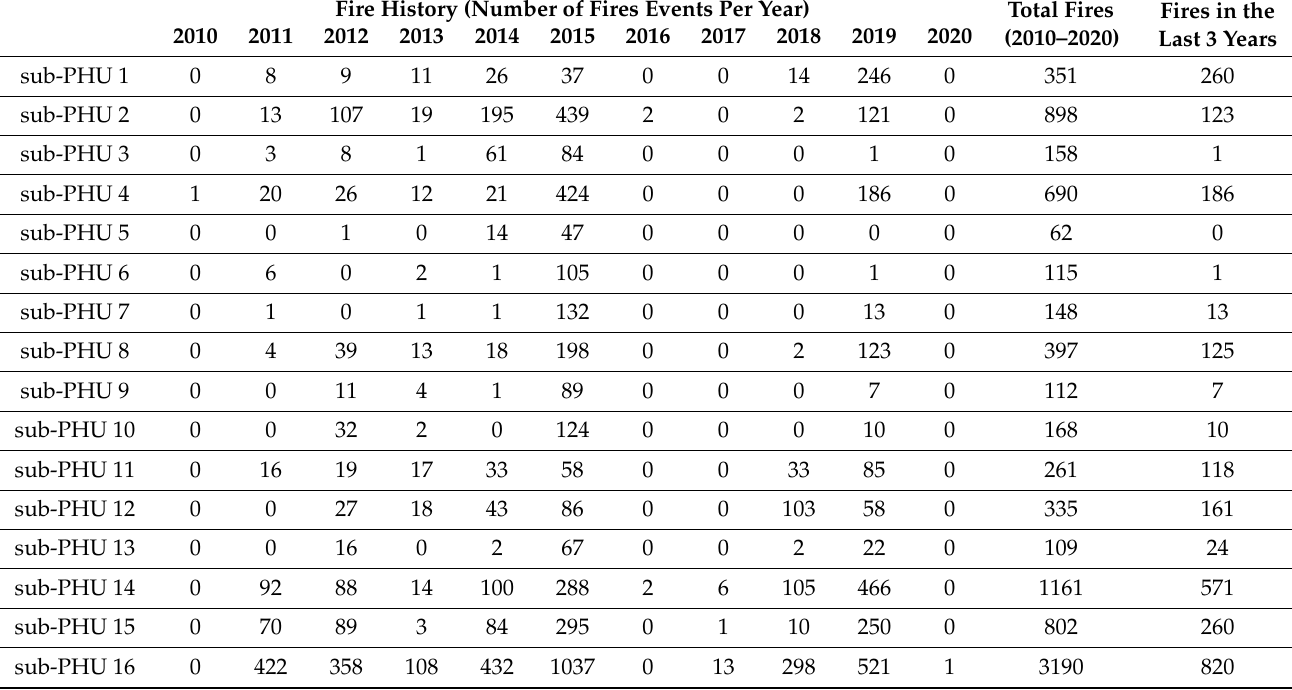
Table 6. The number of yearly fires incidents for each sub-PHU in 2010–2020 (data source: FIRMS; processed by the